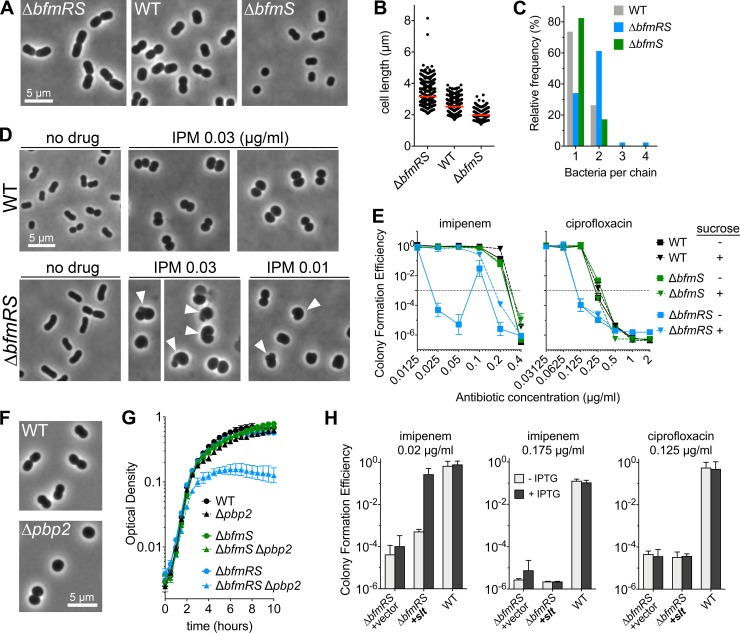
A strategy for BfmRS control of resistance to cell wall stress that is independent of its control of β-lactamase production.(A-C) BfmRS modulates cell morphogenesis. (A) Mid-log phase bacteria were imaged with phase contrast optics. (B) Cell length from n > 300 cells per strain was quantified; Red lines indicate median values. Mutants differed significantly from WT (P <0.0001, Mann-Whitney test). (C) Chaining was quantified for bacteria counted in panel B. Histogram shows frequency of chains containing the indicated number of cells. One chain of 5 cells and one chain of 10 cells were observed with ΔbfmRS but are not included in histogram. (D) Bacteria lacking bfmRS experience cell morphology defects (arrowheads) at low concentrations of imipenem (IPM). Mid-log phase cultures were treated with imipenem at the indicated concentration for 2 hours and bacteria were imaged as in A. (E) Selective suppression of the resistance defect of ΔbfmRS bacteria with 7.5% sucrose. Bacteria were grown on solid medium containing increasing concentrations of the indicated antibiotics, as well as 0 or 7.5% sucrose, and CFE determined. Data points show geometric mean ± s.d. (n = 3). (F) pbp2 deletion causes loss of rod morphology and propagation as spheres. Bacteria were grown to log phase in antibiotic-free LB medium and imaged via phase-contrast microscopy. (G) bfmRS deletion amplifies growth defect caused by pbp2 deletion. Bacterial growth was measured as change in optical density during 37°C incubation (Materials and Methods). Data points represent mean ± s.d. (n = 3). (H) Increasing slt expression partially suppresses imipenem hypersensitivity in cells lacking BfmRS. EGA495 (ΔbfmRS) harboring vector control (pEGE305) or derivative with slt gene downstream of T5-lacp promoter (pEGE316) were grown on solid medium containing the indicated antibiotic supplemented with or without IPTG at 1mM. Data points show geometric mean of CFE ± s.d. (n = 3). 17978 WT was included as additional control (n = 2).